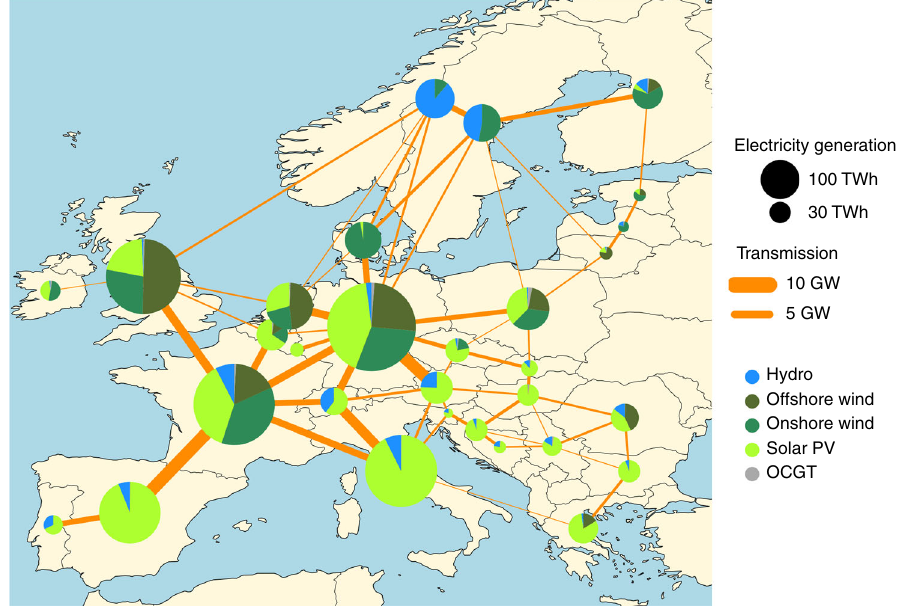
Fig. 6 Electricity generation in 2050 in the Early and Steady path. Evolution of the electricity mix throughout the transition and country-speci fi c results are included in Supplementary Fig. 16.